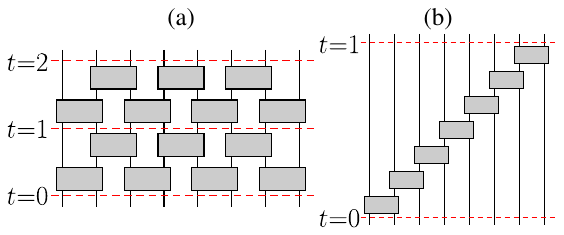
FIG. 1. Overview of purity entanglement generation rates r random circuits with different gates and ordering of NN gates: random (rand.) vs BW vs S. See Fig. 2 for the BWand S